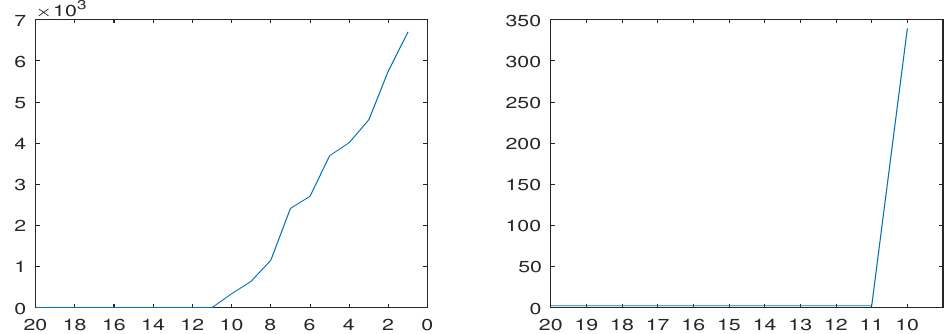
Figure 7: Left side: | λ 20 ( A n ) | < ··· < | λ 1 ( A n ) | ; right side: | λ 20 ( A n ) | < ··· < | λ 10 ( A n ) | in a typical realization in case (b) of Example 5.6.